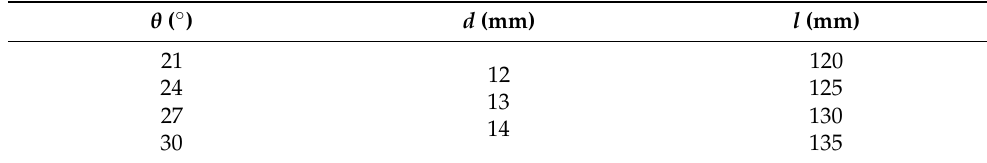
Table 3. The values of the test parameters.